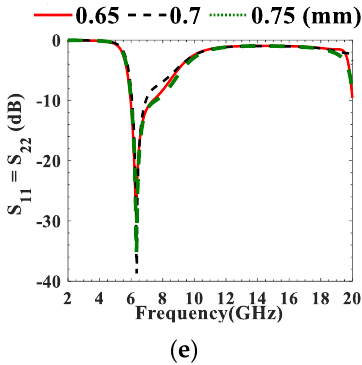
Figure 8. Parametric studies of the proposed NTL IBPF at (5.975 – 7.125 GHz) (a) S , (b) L t , (c) W p1 , (d) W p2 , and (e) rvia .